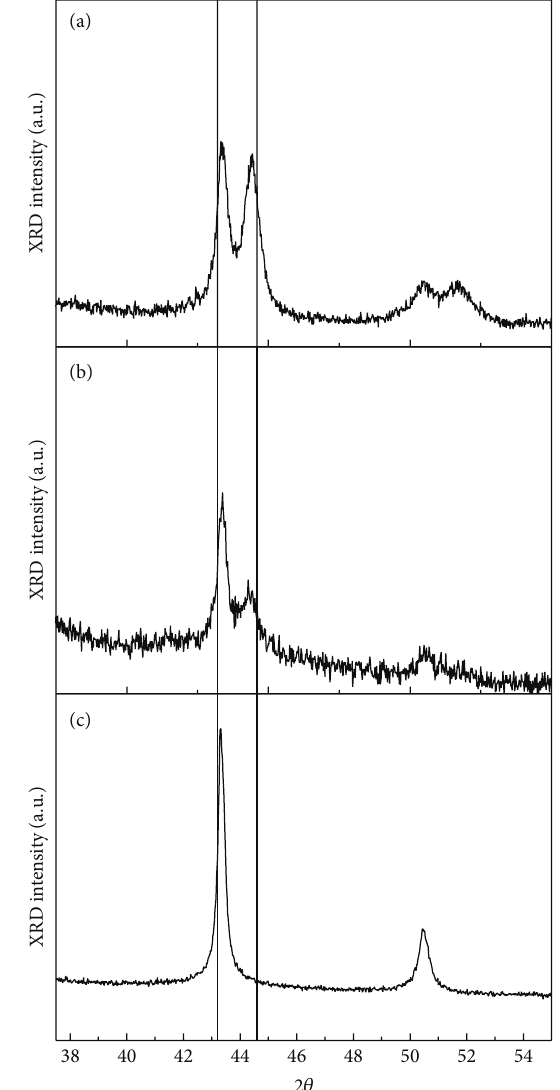
Figure 1: XRD spectra of colloidal: (a) Cu 20 Ni 80 , (b) Cu 50 Ni 50 , and (c) Cu 80 Ni 20